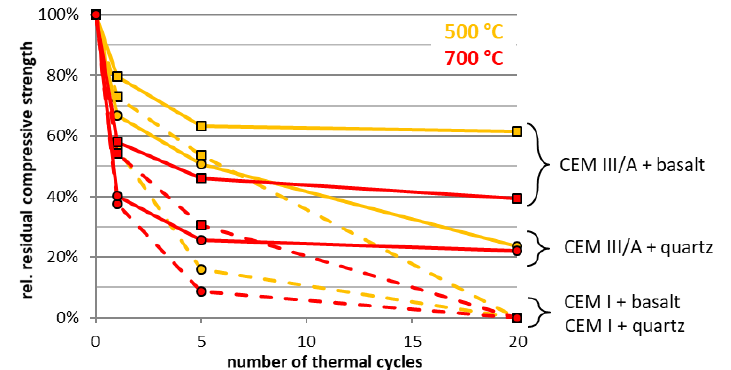
Figure 4. Combined e ff ects of type of cement and aggregate on the residual compressive strength after cyclic heating with maximum temperatures of 500 ◦ C and 700 ◦